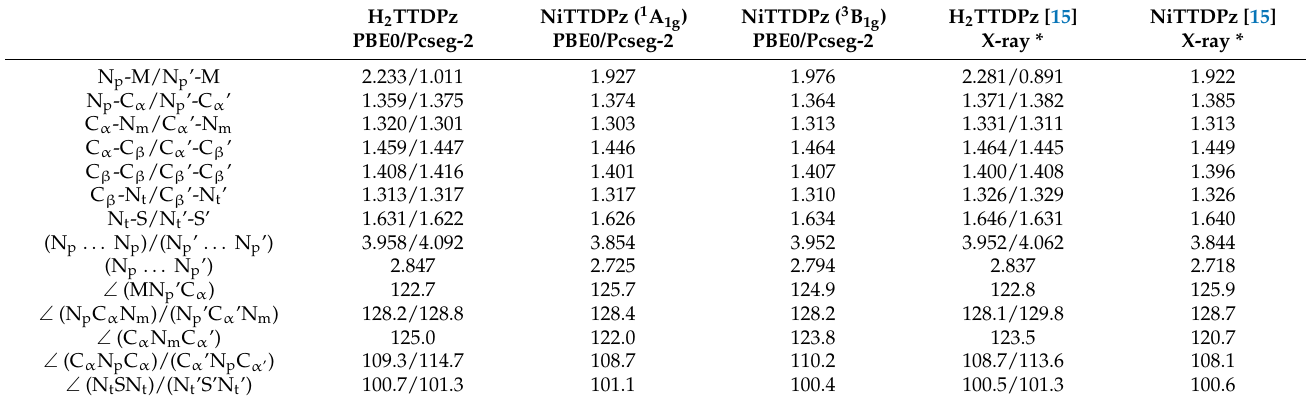
Table 3. Internuclear distances (r, in Å) and valence angles ( ∠ , in deg.) of H 2 TTDPz and NiTTDPz.